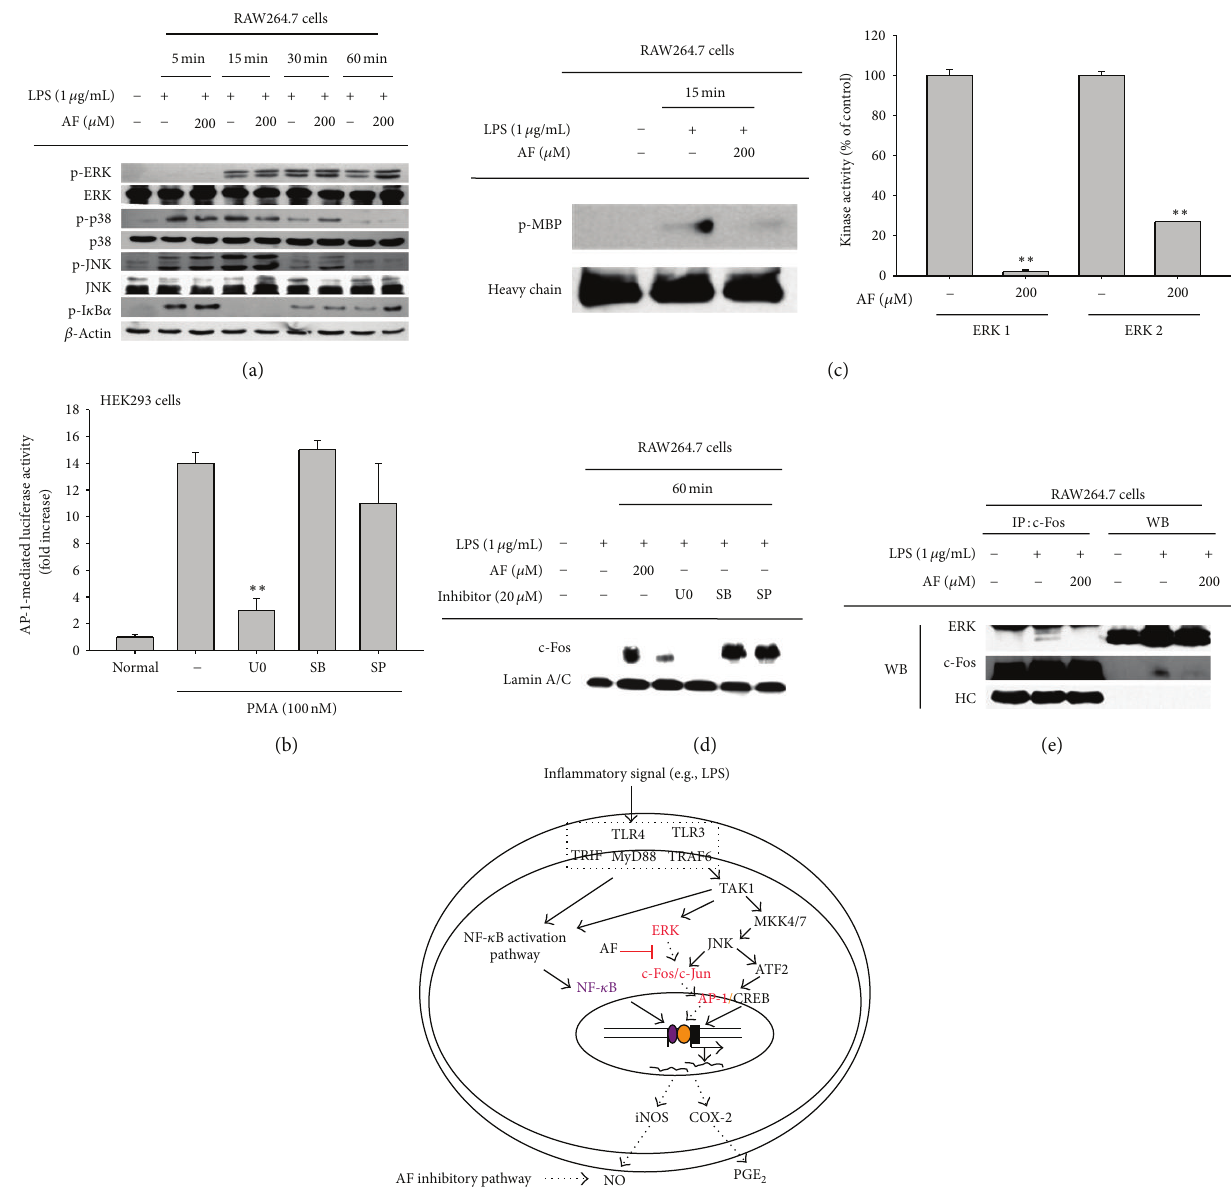
Figure 4: Effect of amentoflavone on signaling factors upstream of AP-1. (a) Phosphorylated and total protein levels of ERK, p38, JNK, and 𝛽 -actin in RAW264.7 cell lysates were determined by immunoblotting analyses using phosphospecific or total protein antibodies. Relative intensitieswerecalculatedbydensitometricscanning.(b)HEK293cellscotransfectedwithanAP-1-Lucplasmidconstruct(1 𝜇 g/mL)and 𝛽 -gal (as a transfection control) were treated with U0126 (U0, 20 𝜇 M), SB203580 (SB, 20 𝜇 M), or SP600125 (SP, 20 𝜇 M) in the presence or absence of PMA (100nM). Luciferase activity was measured using a luminometer. (c) The kinase activities of immunoprecipitated ERK prepared from LPS-treated RAW264.7 cells and purified ERK (ERK1 and ERK2) were determined in a direct kinase assay using purified enzymes or by measuring the level of phospho-MBP. The control (set as 100%) was the activity of each enzyme (ERK1 or ERK2) obtained after treatment with vehicle. The level of phosphorylated MBP was measured by immunoblotting analysis. (d) The total level of c-Fos in the nuclear fraction of LPS-treated RAW264.7 cells after U0, SB, or SP treatment was determined by immunoblotting analyses using specific antibodies. (e) An interaction between ERK and c-Fos was evaluated by immunoprecipitation and immunoblotting analyses. RAW264.7 cells (5 × 10 6 cells/mL) were incubated with amentoflavone (200 𝜇 M) in the presence or absence of LPS (1 𝜇 g/mL) for 30 min. c-Fos was immunoprecipitated from whole cell lysates using a specific antibody, followed by immunoblotting with antibodies to ERK, c-Fos, and rabbit immunoglobulin heavy chain. (f) Putative anti-inflammatory signaling pathway induced by amentoflavone treatment. ∗∗ 𝑃 < 0.01 compared to the